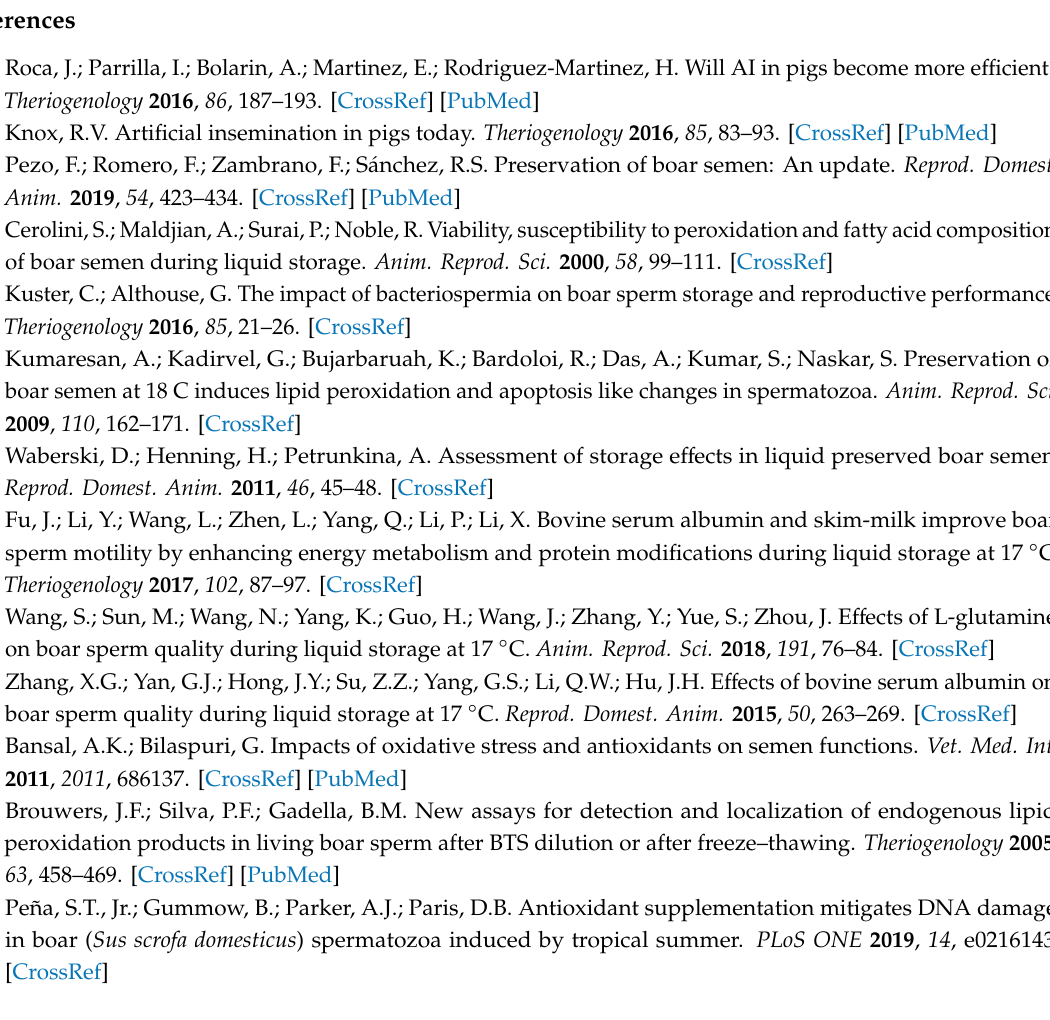
Figure S1: Photomicrographs of sperm stained with PI and SYBR-14, Figure S2: Photomicrographs of the sperm stained with DAPI and FITC-PNA, Figure S3: Photomicrographs of the sperm stained with JC-1, Figure S4: Photomicrographs of the sperm stained with BODIPY 581 / 591 C11, Figure S5: Photomicrographs of the sperm stained with DCFH-DA, Figure S6: Photomicrographs of the sperm stained with DNTB, Table S1: E ff ect of proline on the total motility of boar sperm during liquid storage, Table S2: E ff ect of proline on the progressive motility of boar sperm during liquid storage, Table S3: E ff ect of proline on the motility parameters of boar sperm at the fifth day of